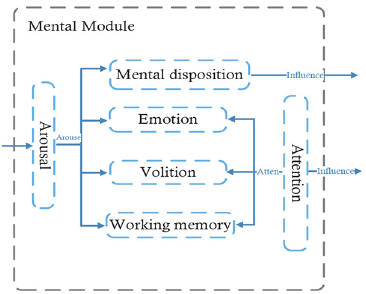
Figure 2. This is the mental factors of the Digital- self of individual and mental disposition includes ability, temperament, personality, values, motives, preferences, intentions,